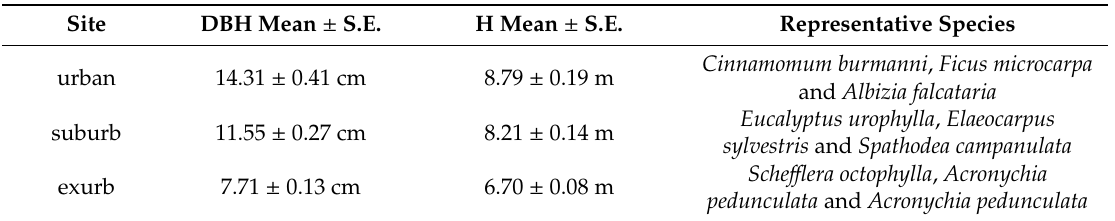
Sche ffl era octophylla ,